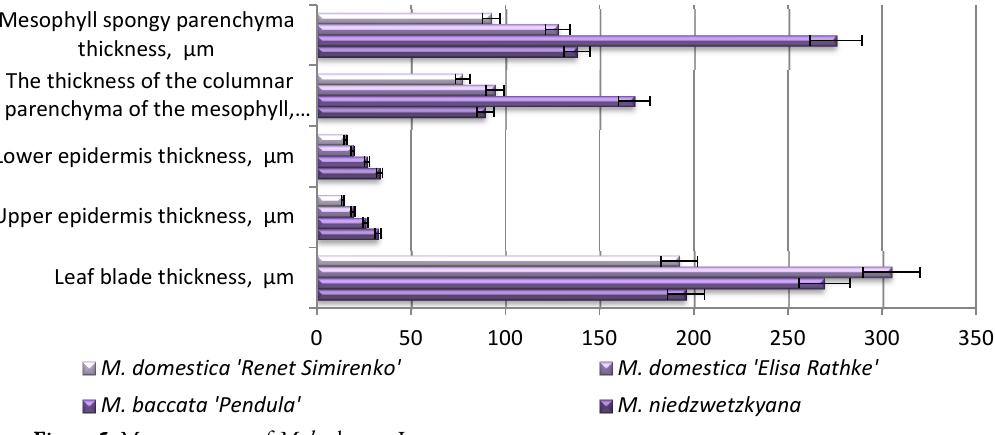
Figure 5. Mesostructure of Malus leaves, June